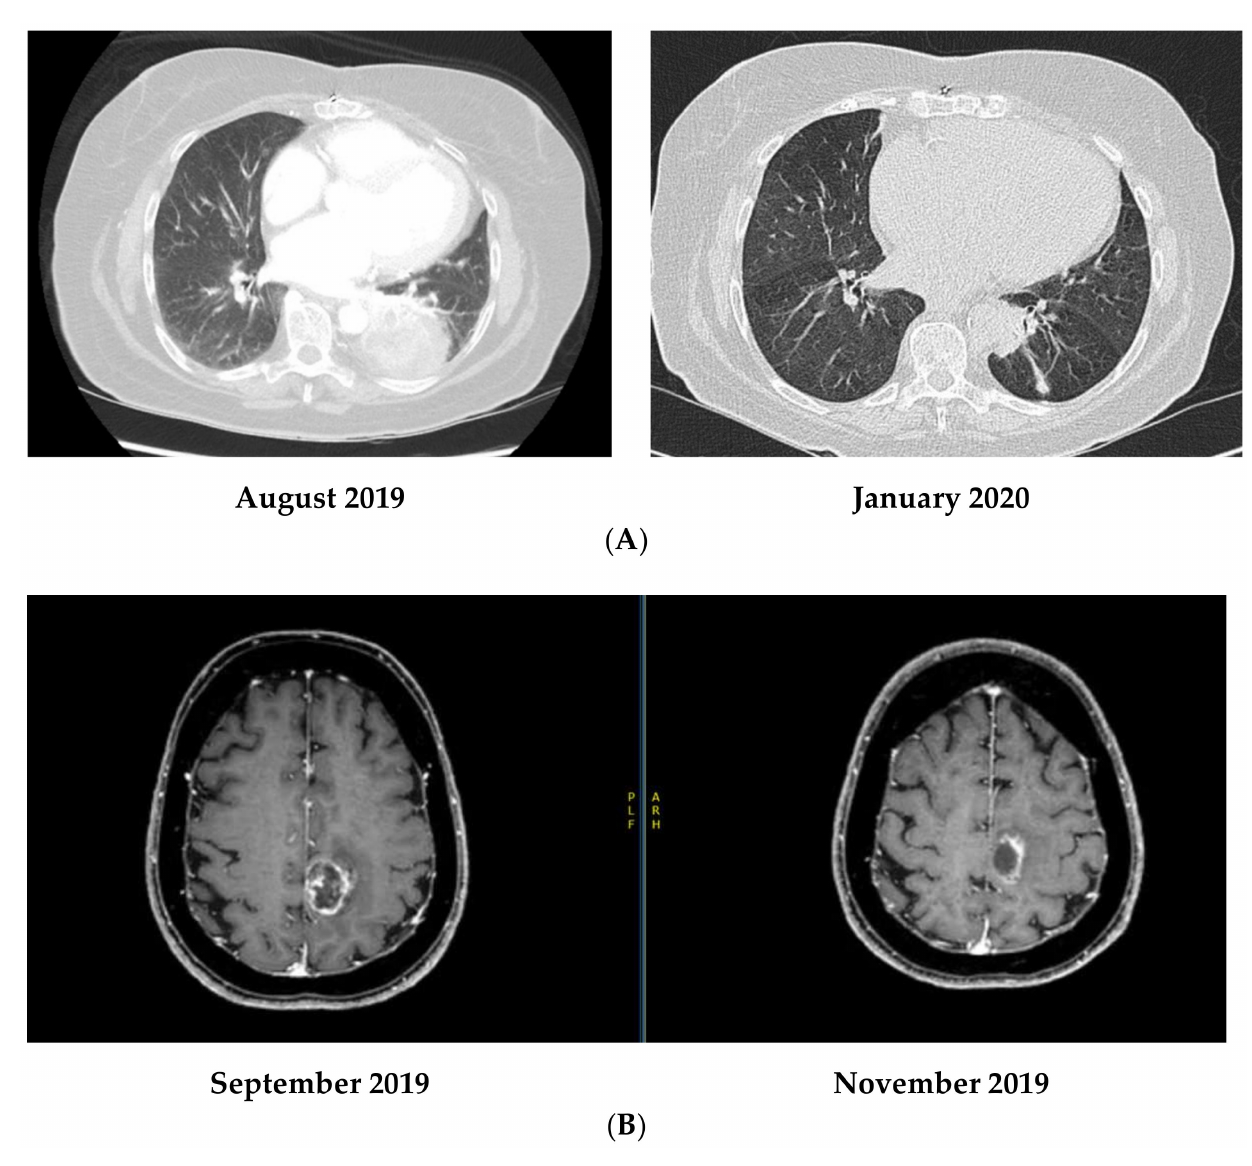
Figure 2. ( A ) Disease response on Alectinib in patient 2. (Comparison between August 2019 and January 2020). ( B ) Variation of brain lesion in patient 2 on Alectinib within less than one month on